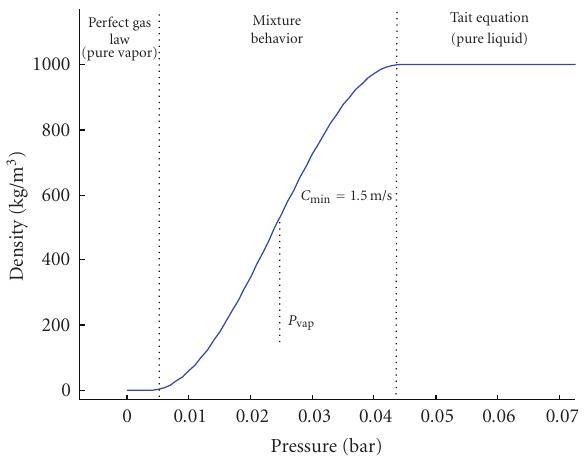
Figure 4: Barotropic state law ρ ( P ); water 20 ◦